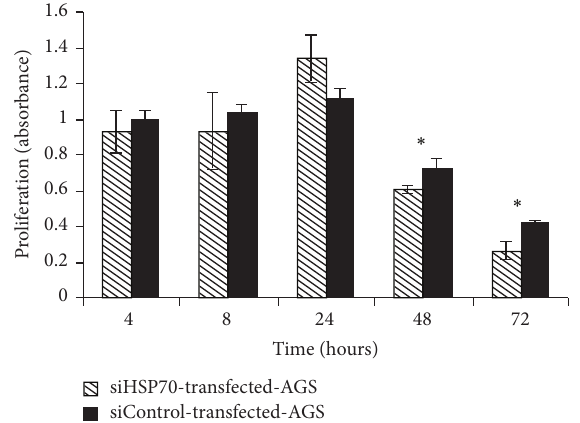
Figure 3: Proliferation of HSP70-silenced AGS line exposed to H. pylori. The HSP70-silenced AGS line (siHSP70-stably transfected- AGS cells) and control cells (siControl-stably transfected-AGS cells) were cocultured with H. pylori (bacteria :epithelial cell ratio 200 :1) for the indicated times. Then, cell proliferation was detected by an MTT assay as described above. The results were expressed as absorbance. The data was shown as means ± SD ( ∗ 𝑃 < 0.05 , when compared with the control